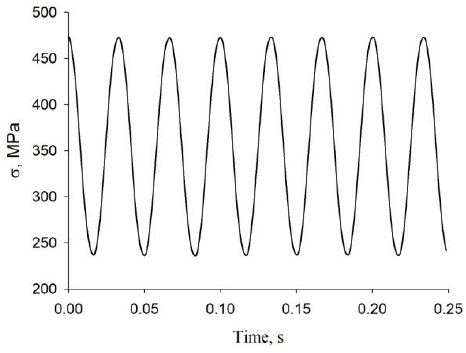
Figure 12. Stress – time curve for fatigue testing of welding joints.